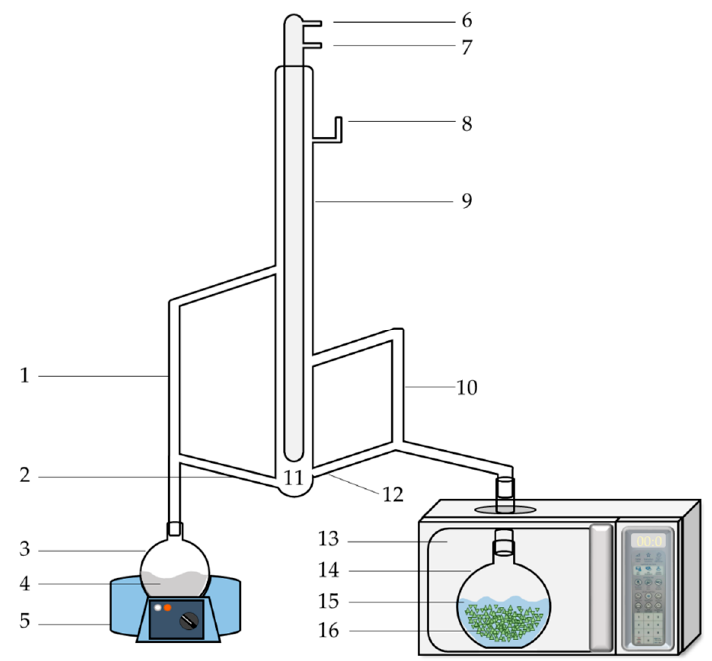
Figure 1. Schematic diagram of MA-SDE